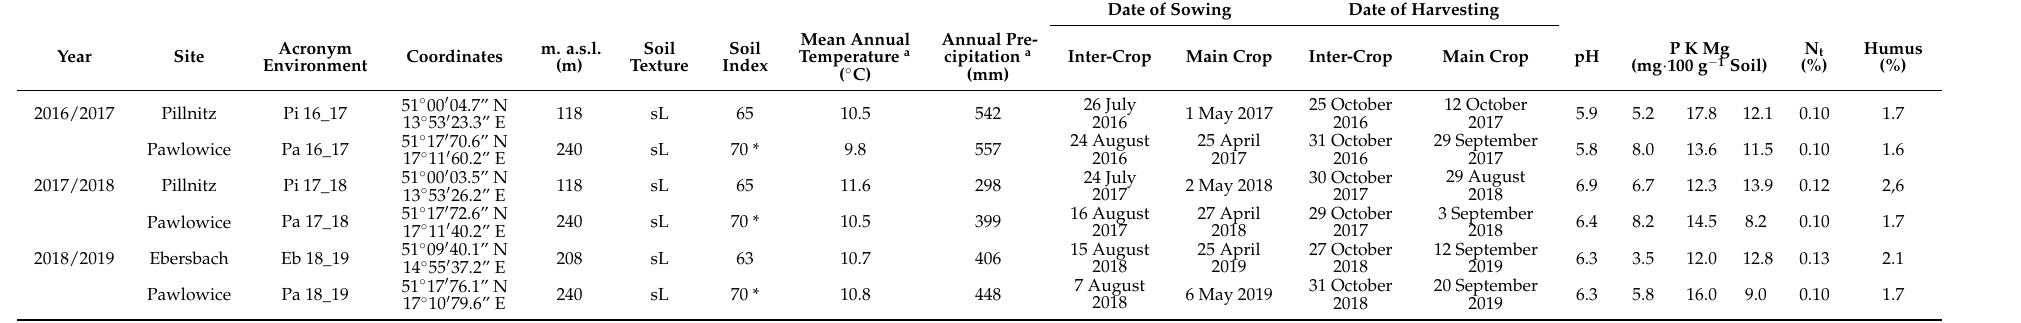
Table 1. Characterization of trial sites.